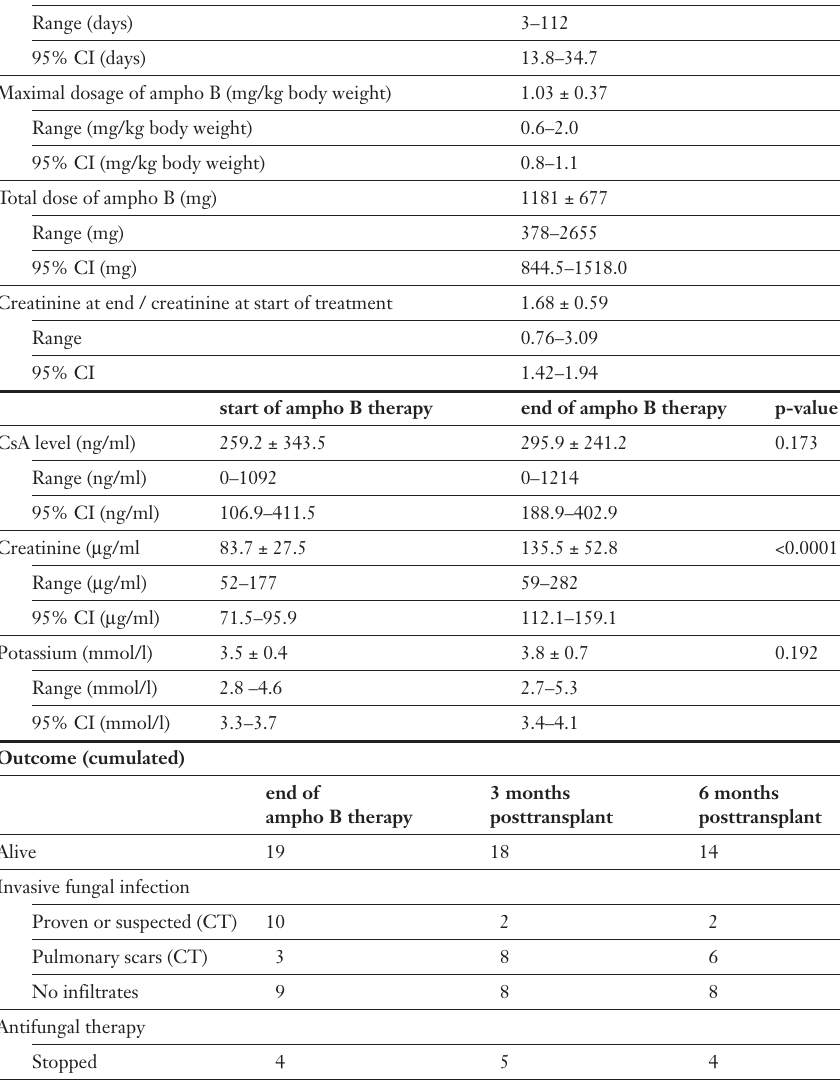
Characteristics of patients: treatment with amphotericin